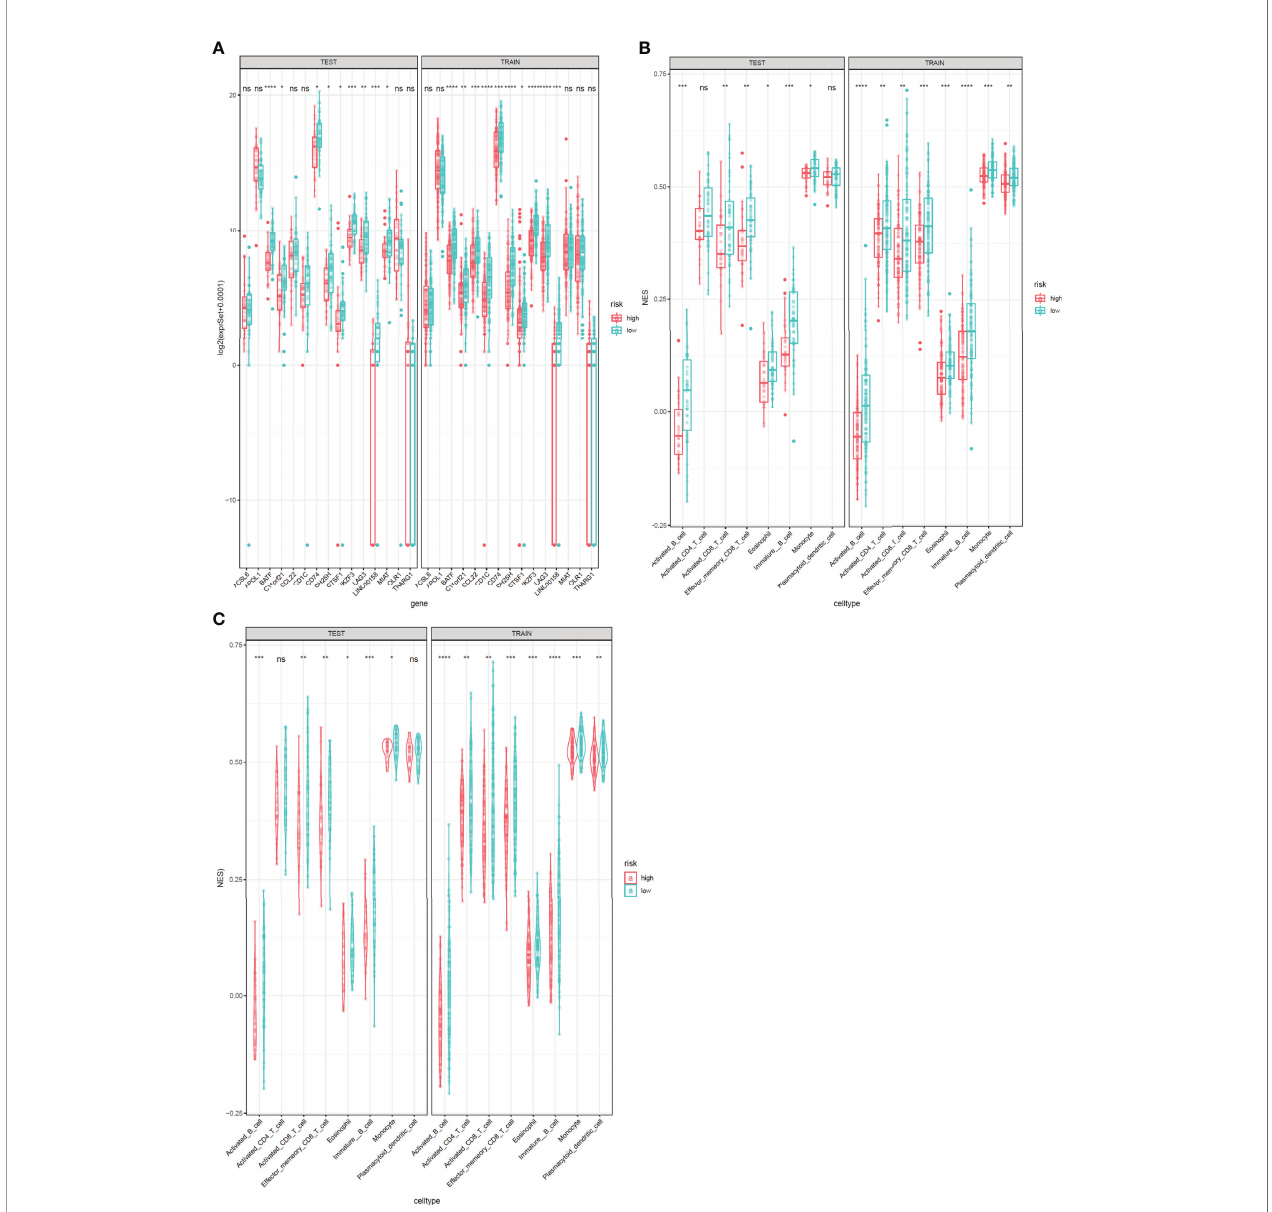
FIGURE 8 | Expression pro fi le of 15 genes and immunophenoscores of eight immune cell subtypes in test and train sets. (A) Expression pro fi le of 15 genes. The test cohort is shown in the left, and the train cohort is shown in the right. (B, C) Immunophenoscores of eight in fi ltrated immune cells in high-risk and low-risk groups based on the integrated classi fi er. The test cohort is shown in the left, and the train cohort is shown in the right. *: P<0.05, **: P<0.01, ***: P<0.001****: P<0.0001, ns, no signi fi